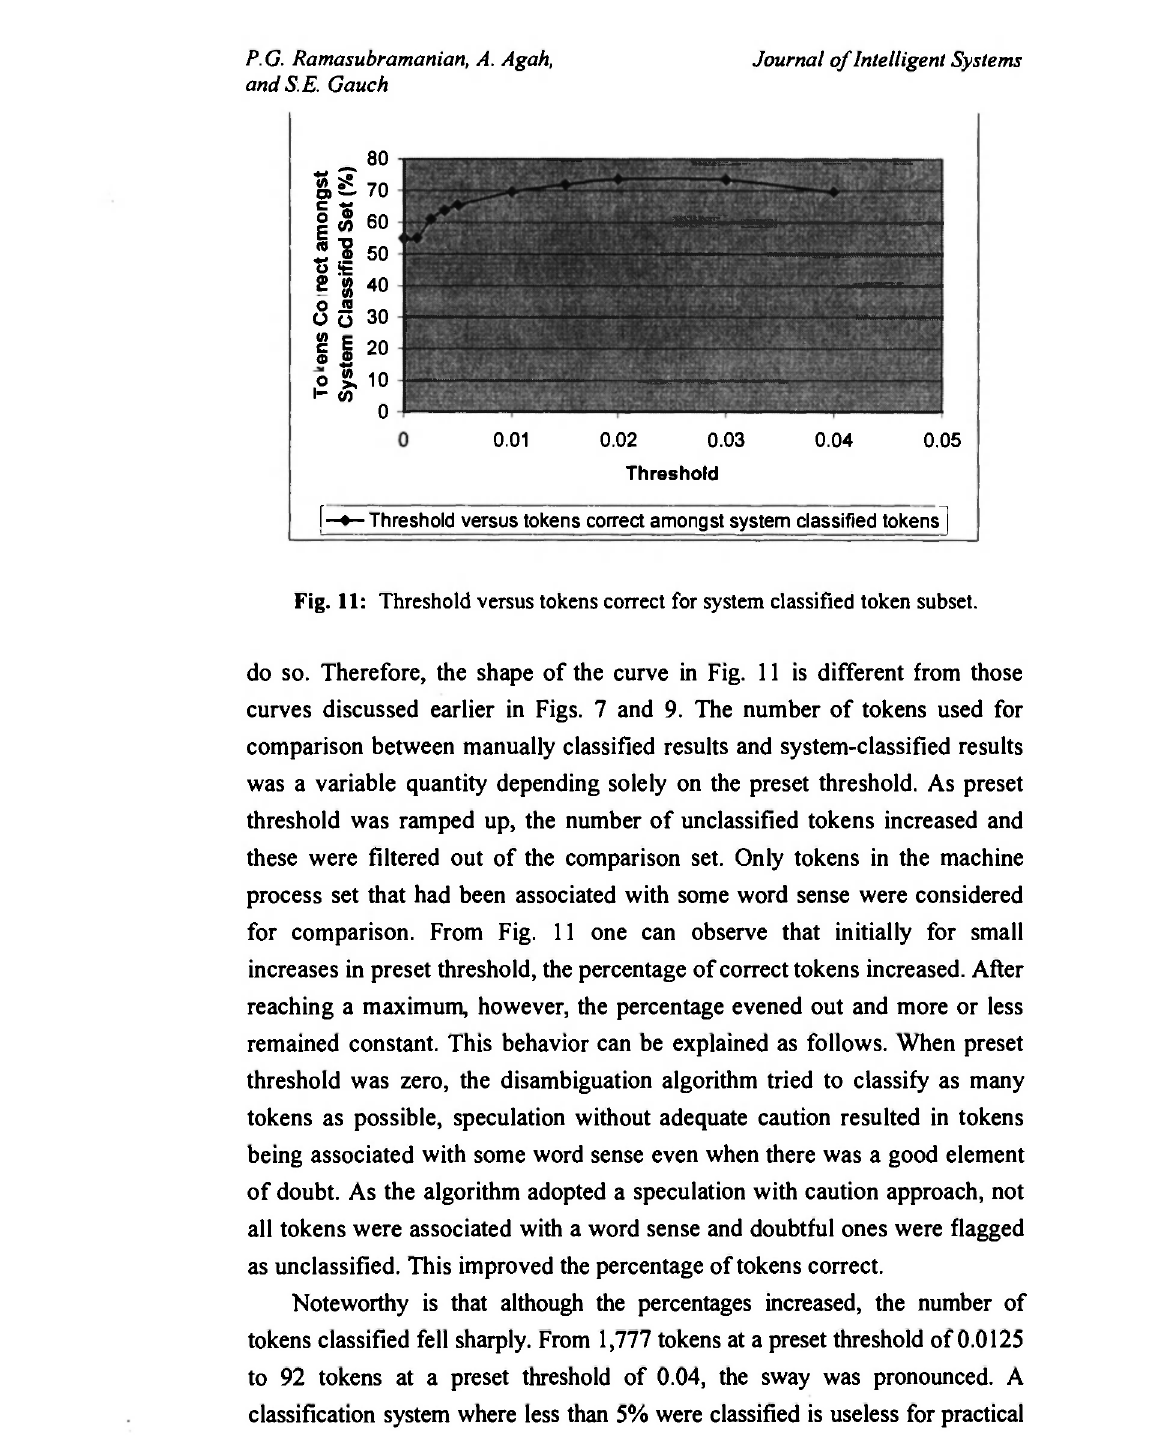
Fig. 11: Threshold versus tokens correct for system classified token subset.